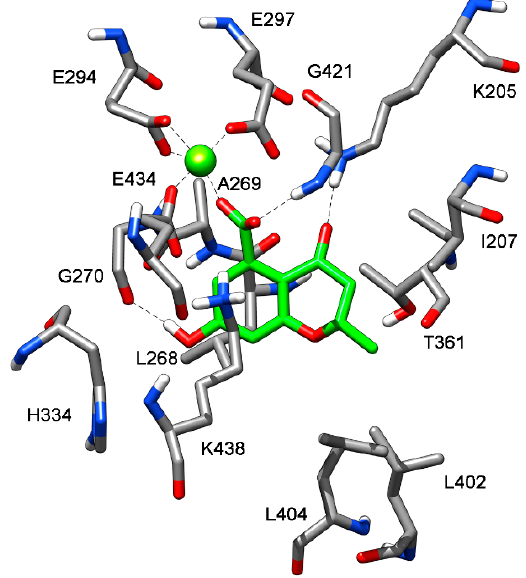
Figure 2. Minimized average structure of 1 docked at MbtI binding site.